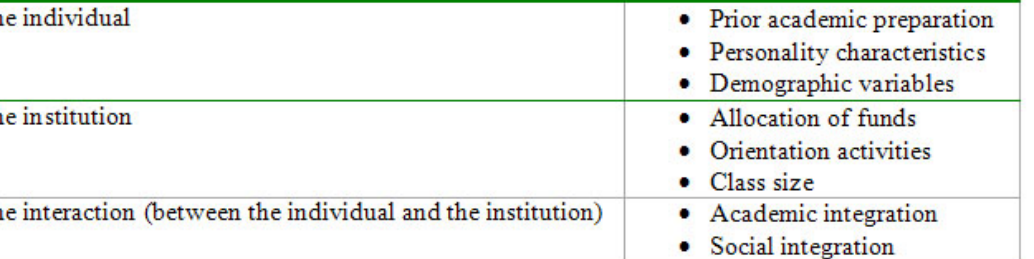
Table 1 . Commonly selected independent variables in persistence research